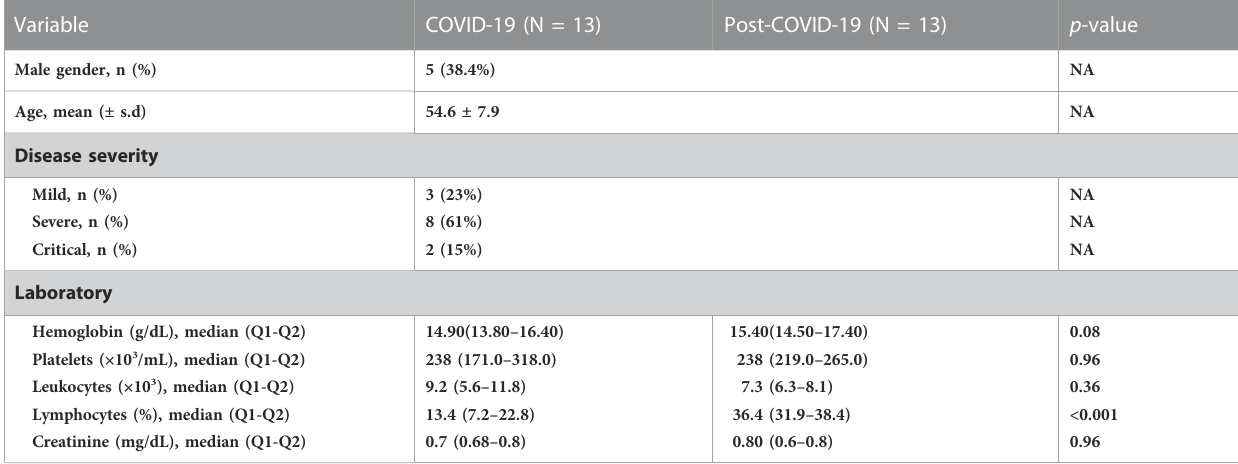
TABLE 2 Clinical characteristics from patients with paired samples 2 years after